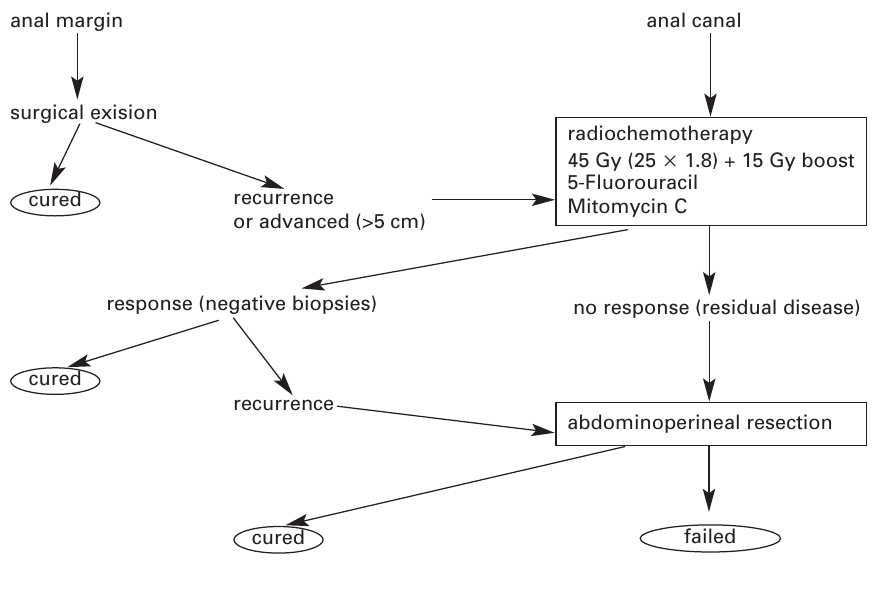
Management algo- rithm of anal